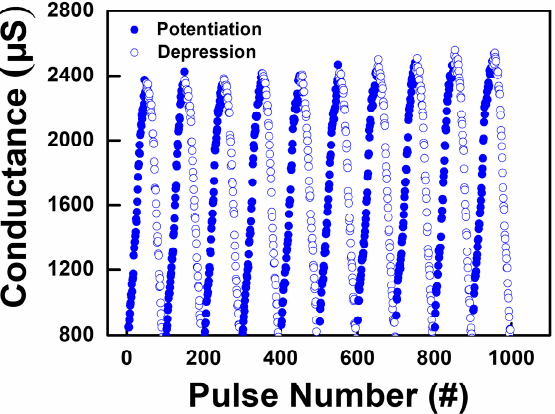
Figure 9. The potentiation and depression characteristics measured for 10 consecutive non-identical pulses.